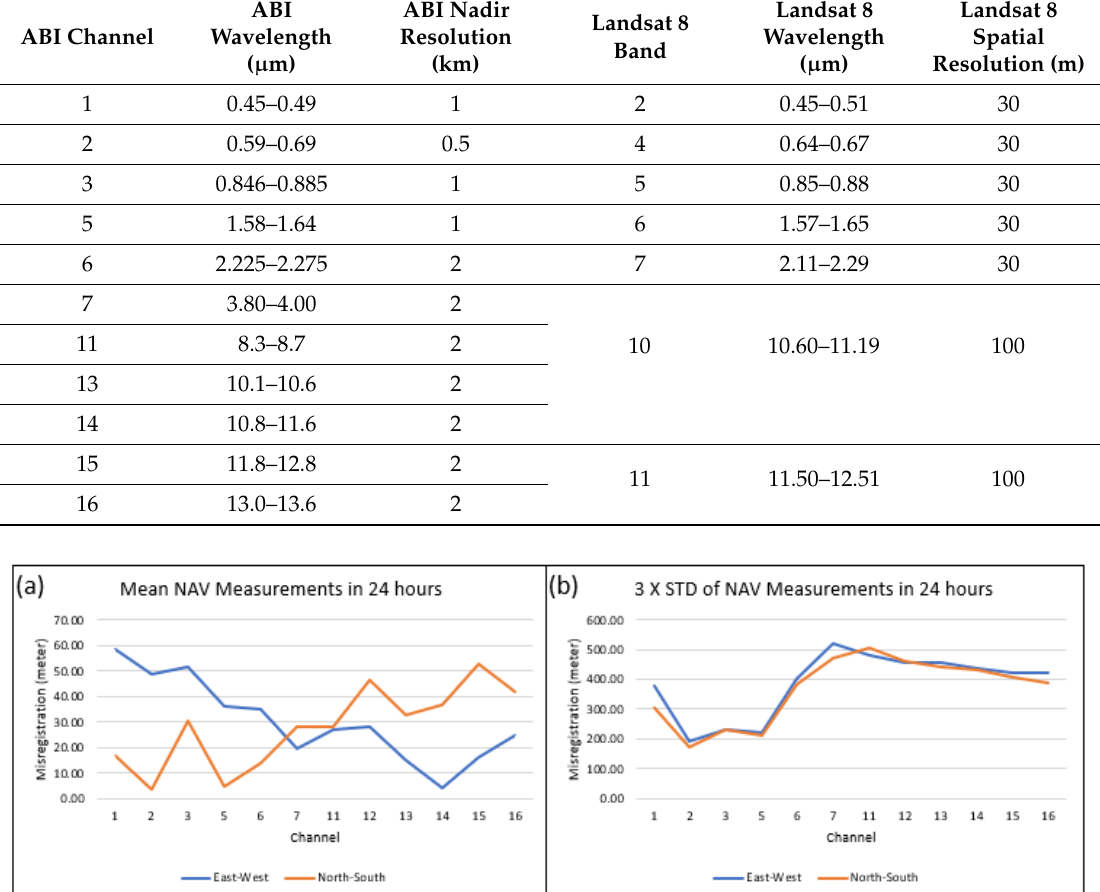
Table 3. ABI channels and the corresponding Landsat channels utilized for Navigation (NAV) measurements. The ABI non-window IR channels are excluded from the NAV measurements (and not included in this table) because they cannot see the ground and so cannot be compared with Landsat chips